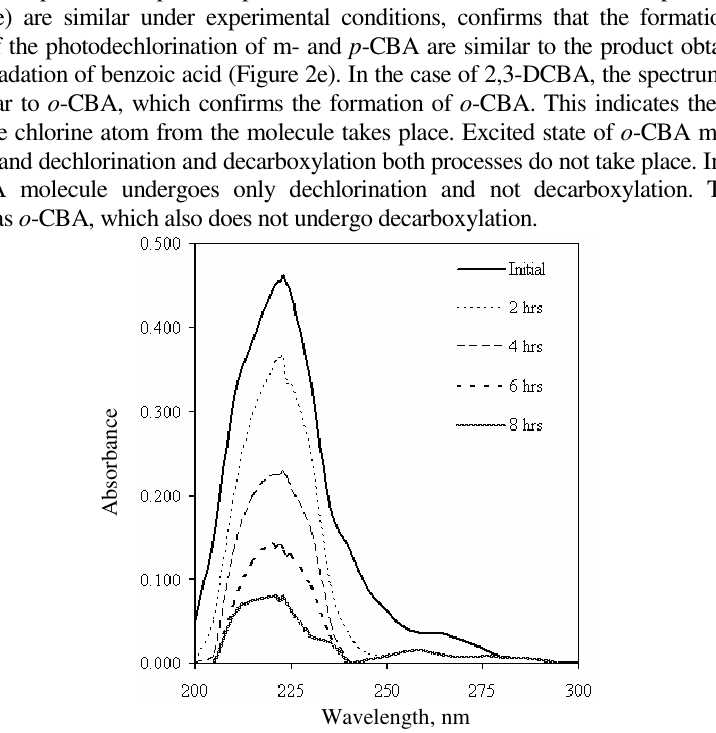
Figure 2e. Spectrum changes of benzonic acid with time [BA] = 5.0 x 10-5 M, [2-Naphthol] = 5.0 x 10 -5 M, light intensity= 11.8 x 10 -8 E sec -1 , pH = 11.5, Temperature = 298